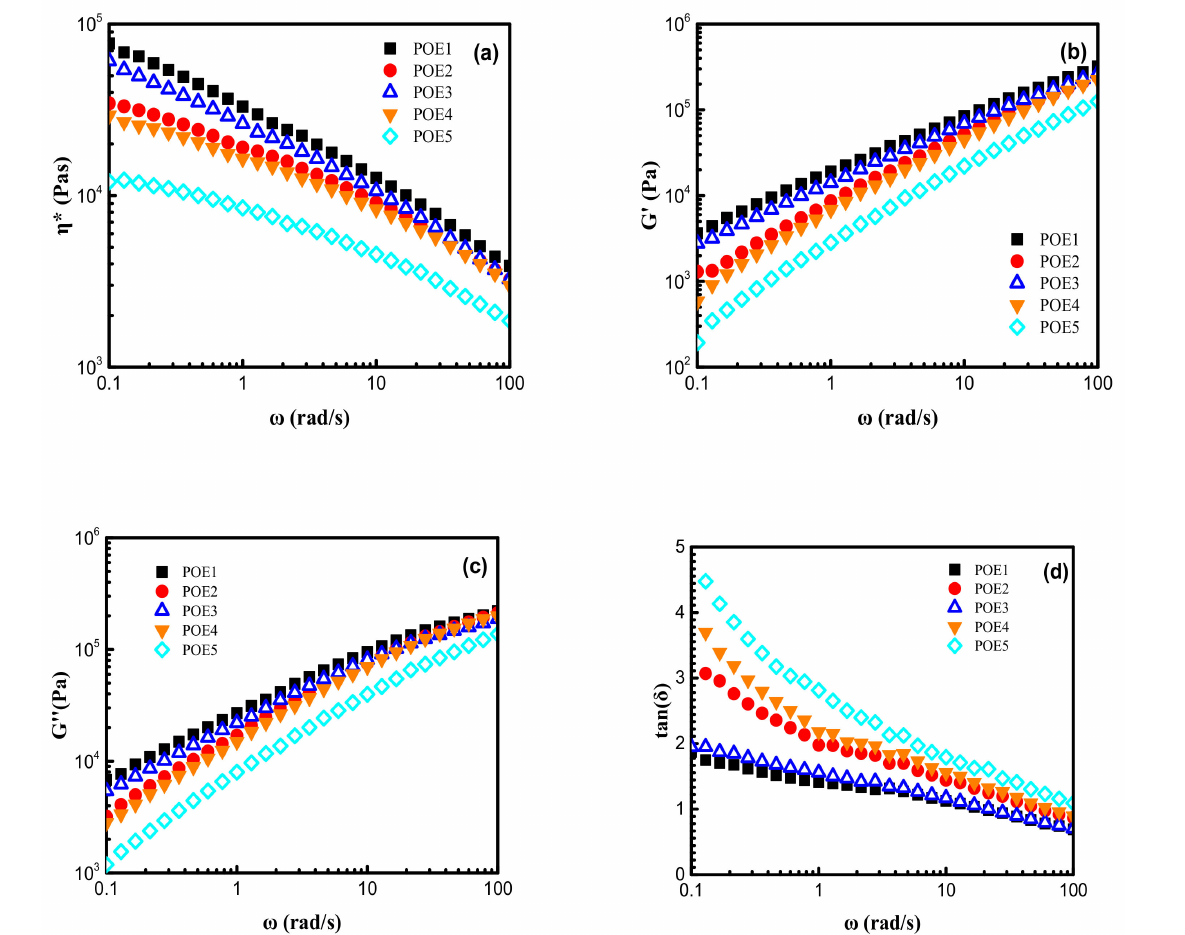
Figure 7. Shear rheological behaviors of POE samples measured at 120 ◦ C in the frequency range between 100 and 0.1 rad/s: ( a ) complex viscosity, η ∗ ; ( b ) storage modulus, G (cid:48) ; ( c ) loss modulus, G (cid:48)(cid:48) ; ( d ) loss angle, tan ( δ )